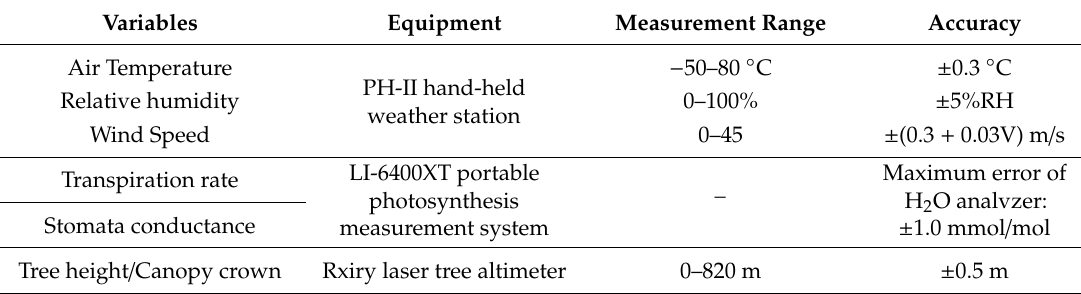
Table 2. Technical details of meteorological